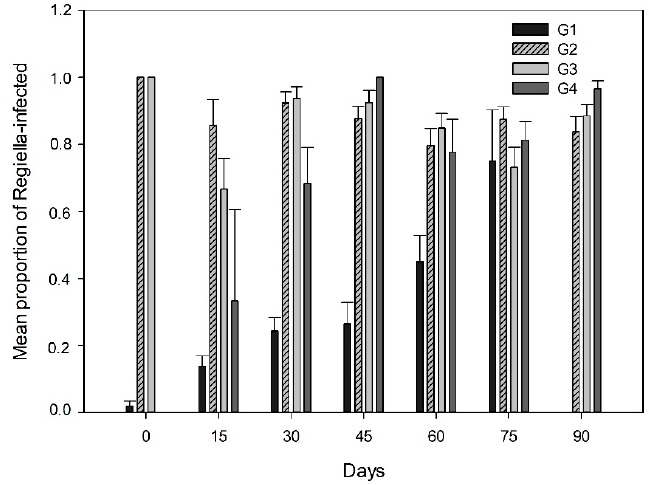
Figure 4. Mean proportion (±SE) of infected aphids with the common endosymbiont R. insecticola in the different aphid clones studied (G1, G2, G3 and G4) across one season.